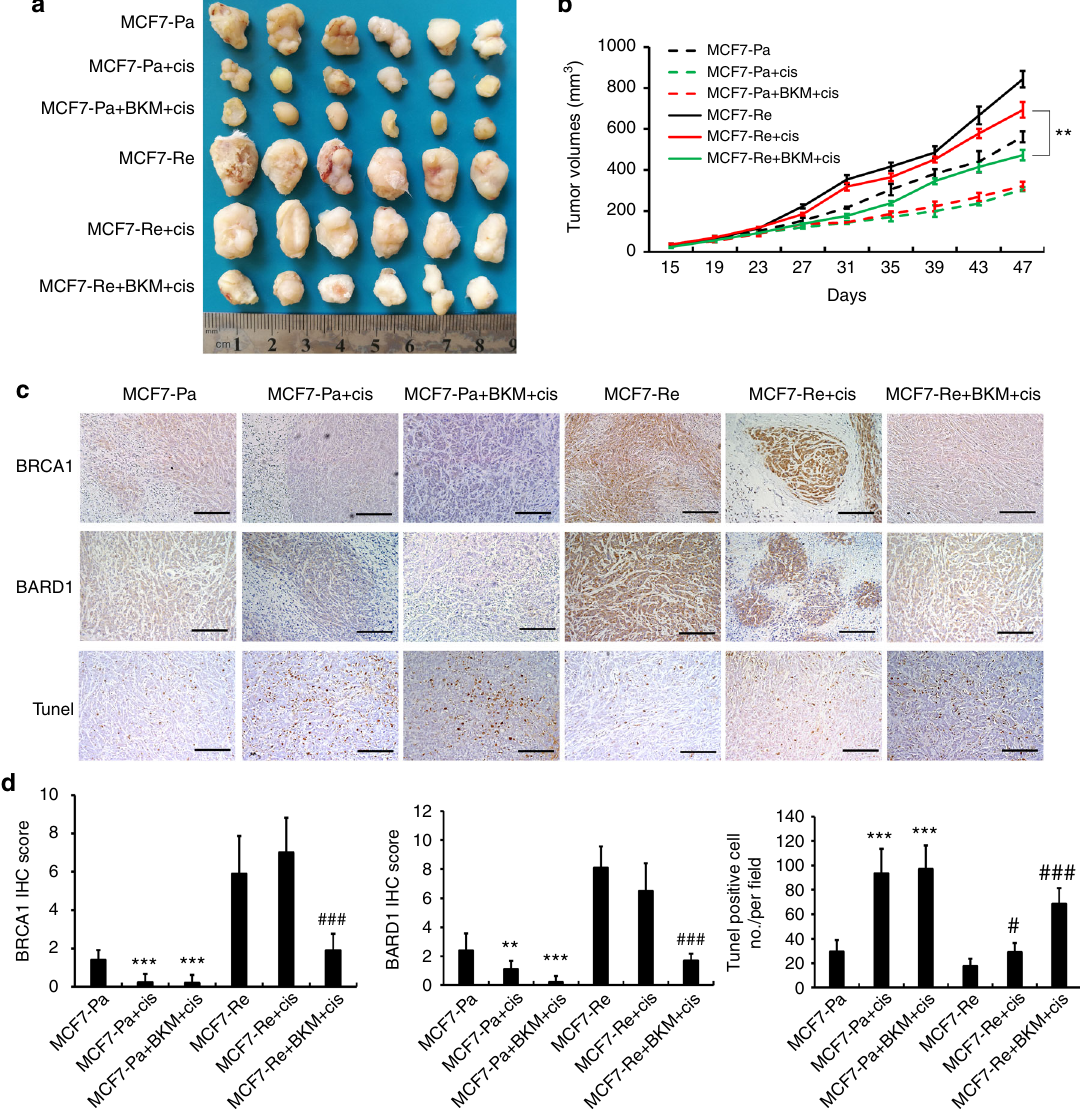
Fig. 5 PI3K inhibitor restores the sensitivity to cisplatin in xenografts of tamoxifen-resistant tumor in vivo. MCF7-Pa and MCF7-Re cells were inoculated into the mammary fat pads of Balb/c nude mice. When tumors became palpable, tumors were treated with control, cisplatin, or cisplatin with BKM120. The picture ( a ), tumor volume ( b ), and immunohistochemical staining of BARD1/BRCA1 and Tunel staining ( c ) of xenografts derived from MCF7-Pa and MCF7- Re cells with indicated treatment. d IHC scores of BRCA1 and BARD1 and Tunel-positive cell number counts in indicated xenografts. In b , d , data show means ± s.d. ( n = 6) ** p < 0.01 by Student ’ s t test. Scale bar indicated 400 µ